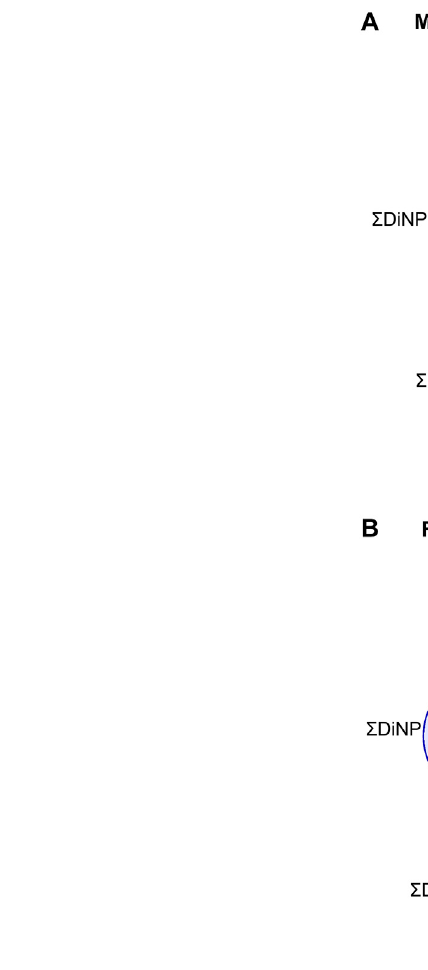
Frontiers in Genetics |